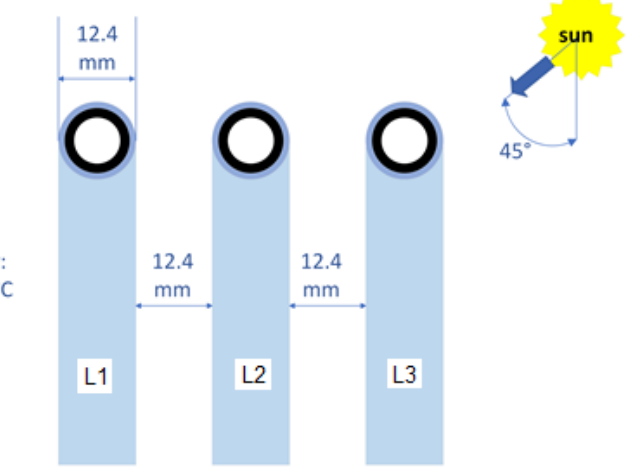
Figure 1. The analyzed power cable line composed of three single-core cables.